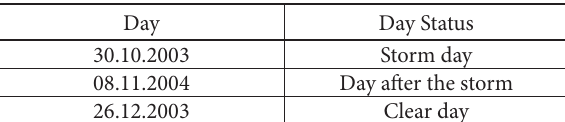
Table 4. Analyzed days